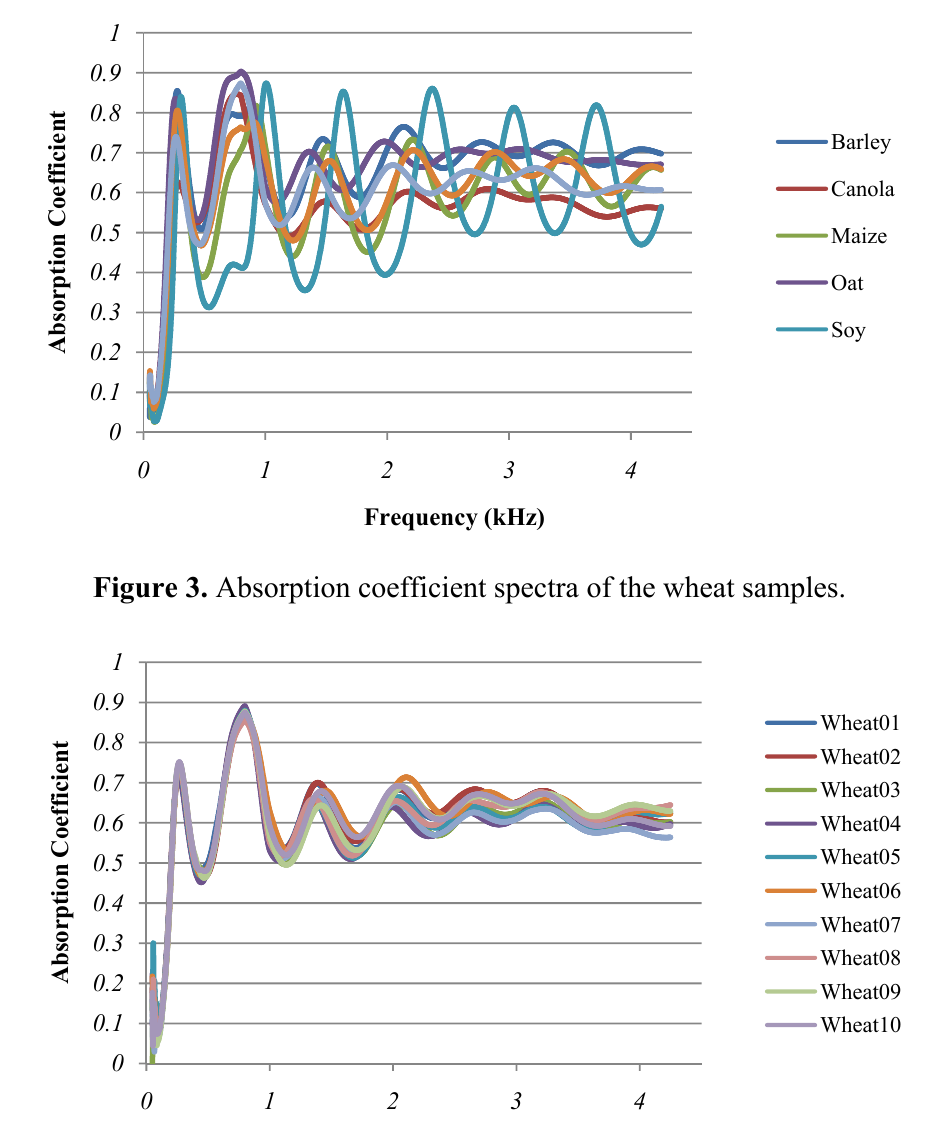
Figure 2. Absorption coefficient average spectra of the different seed types.